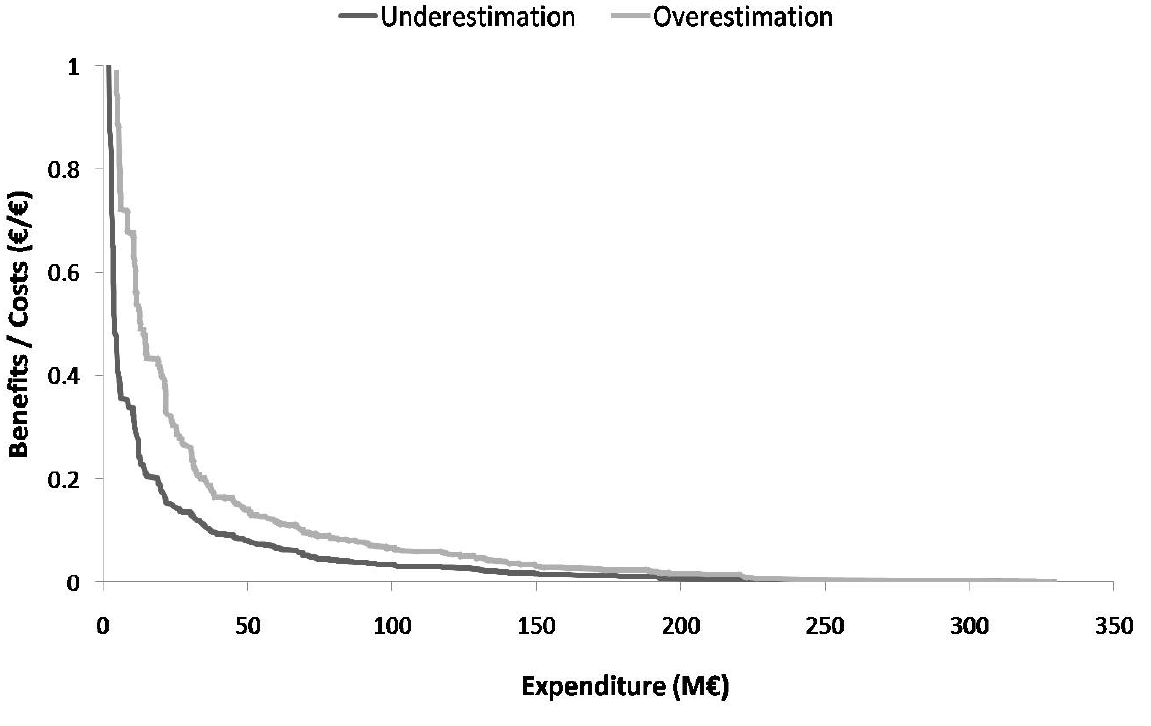
Figure 5. Variation of the benefit and cost ratio as a function of the acceptable expenditure to improve the ecological status of water resources for both under- and over-estimation of non-use